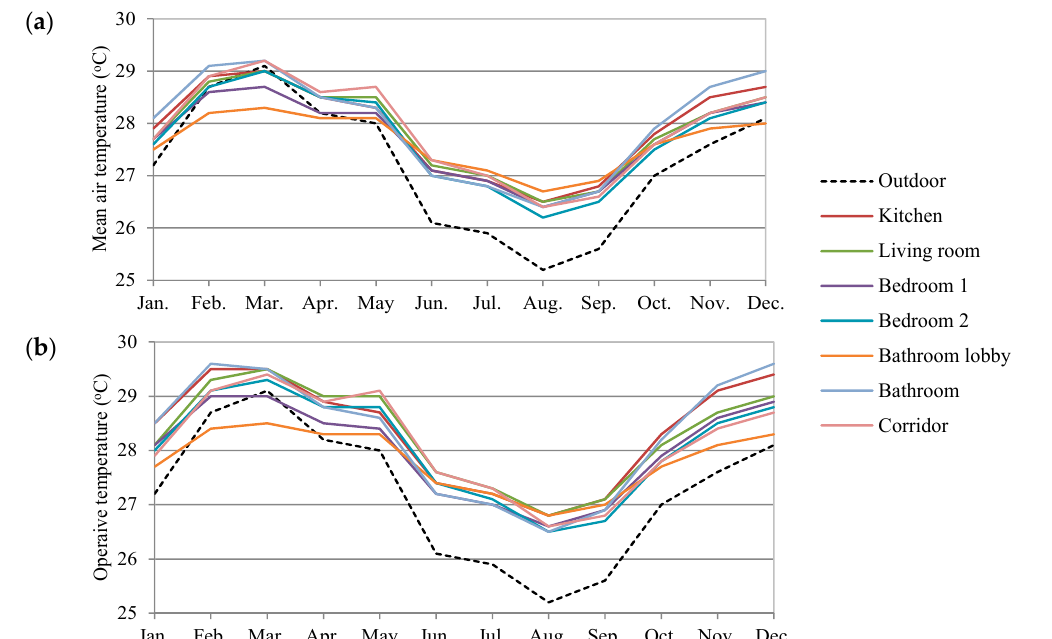
Figure 7. Profiles of monthly mean indoor air ( a ) and operative temperatures ( b ) for the individual zones of the building when simulated with the recent climate data.